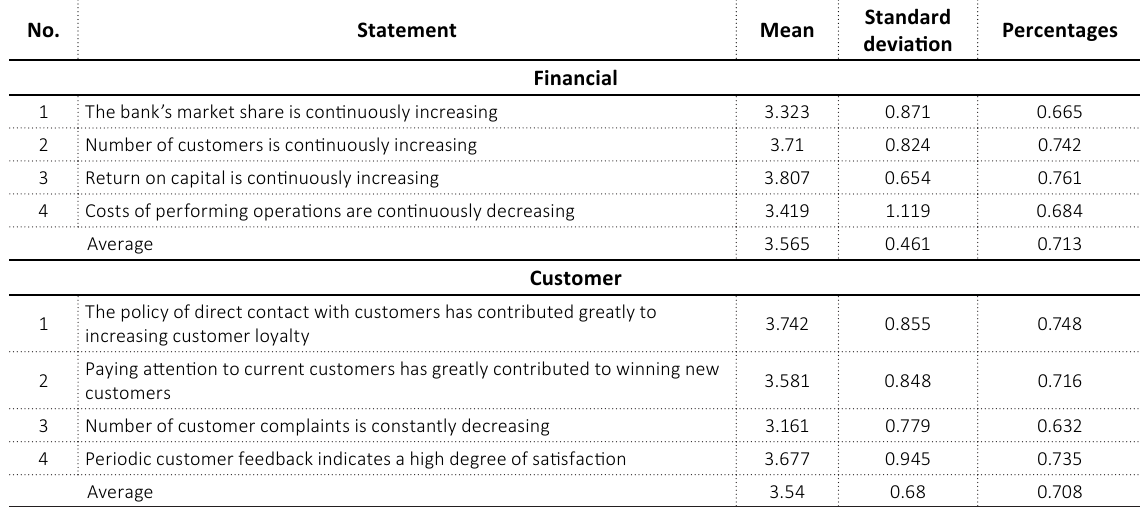
Table 4. Descriptive statistics of responses for dependent variables (strategic performance)